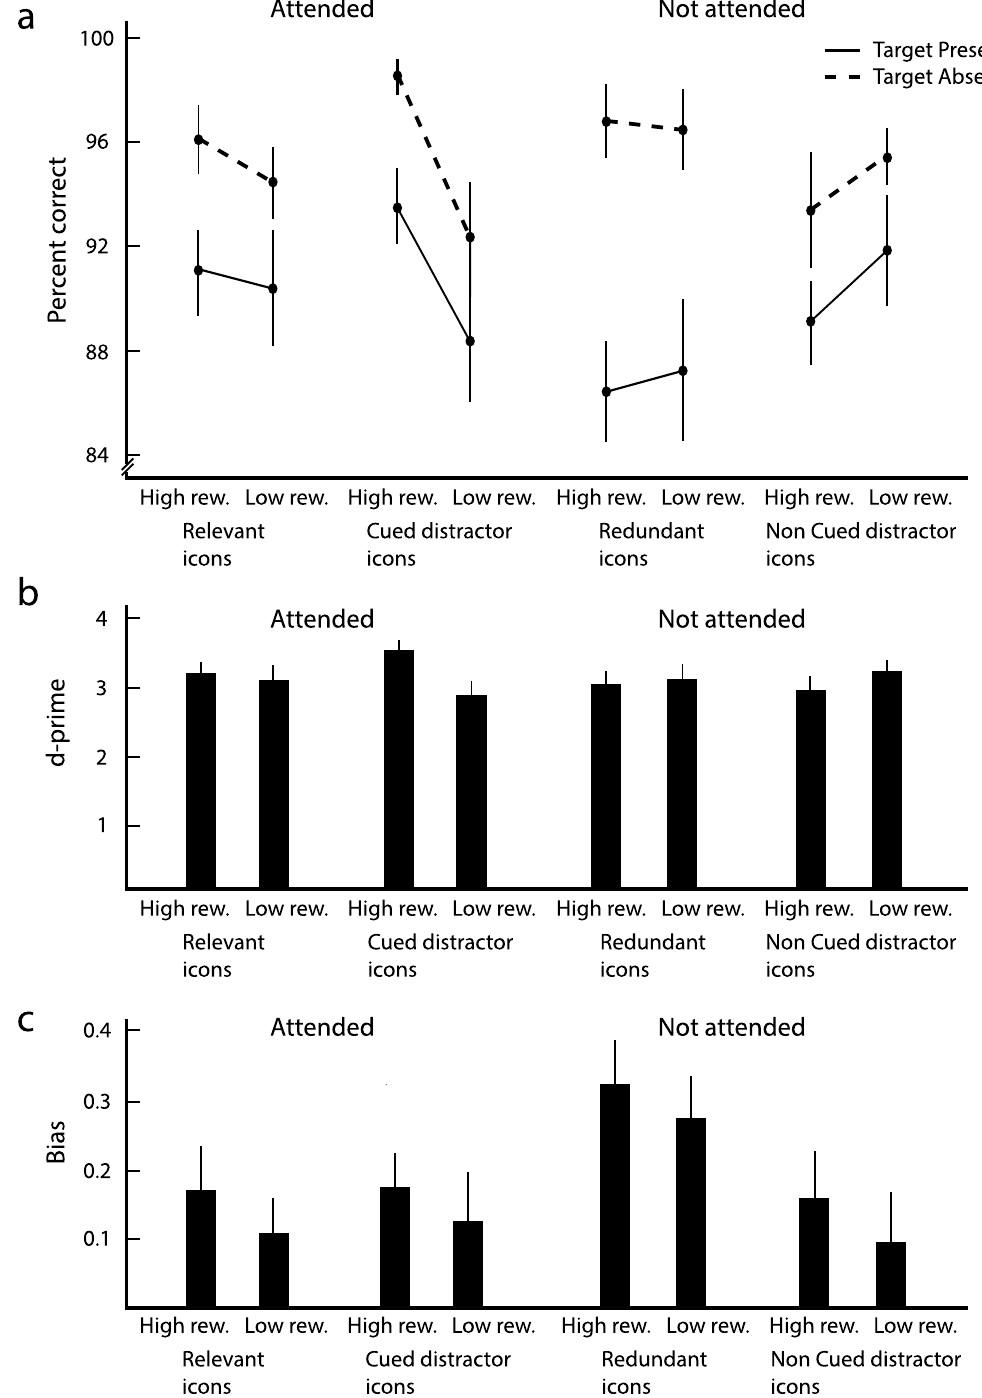
Figure 4. Accuracy in the visual search task. ( a ) Mean accuracy on trials in which subjects searched for the various types of icons of the learning task with different reward values. ( b ) Sensitivity (d-prime) for these icons. ( c ) Bias for the icons. Higher bias values correspond to a more conservative response criterion, i.e. a decreased probability to report “Target present”. Error-bars, s.e.m. across